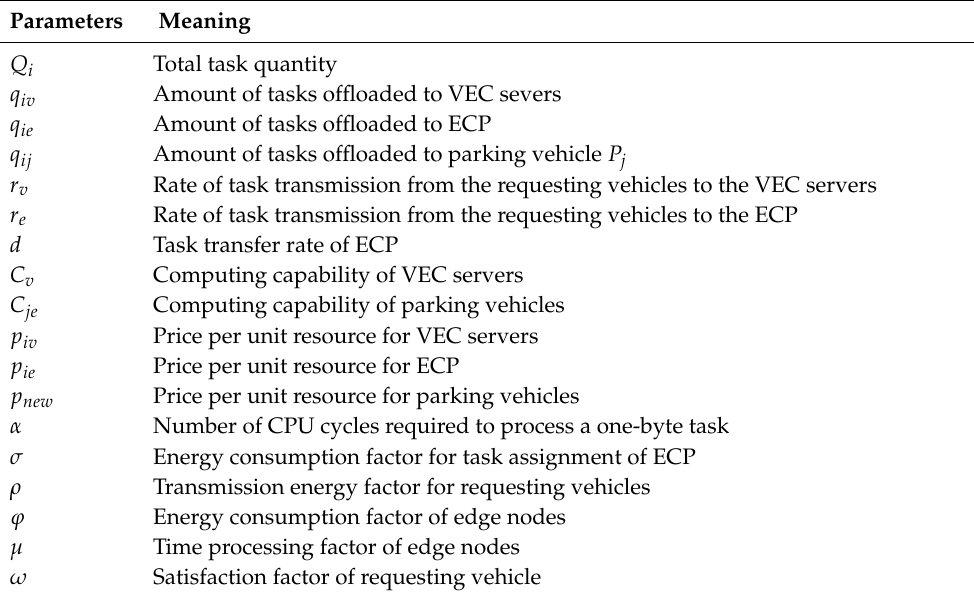
Table 2. Main notation used in this